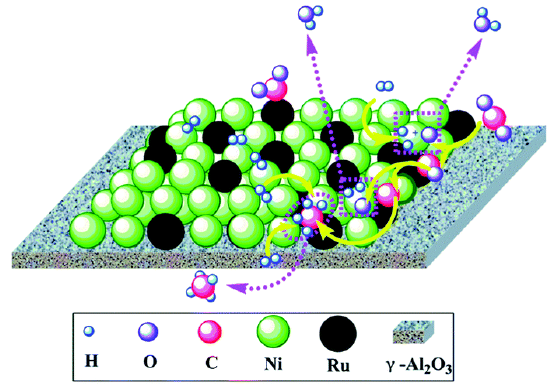
Figure 9. The proposed a possible reaction mechanism of CO 2 methanation over 10Ni–1.0Ru catalyst. Reproduced with permission from [30]. Copyright: Royal Society of Chemistry, London, UK, 2014.